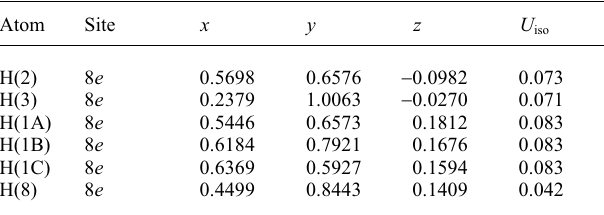
Table 2. Atomic coordinates and displacement parameters (in Å 2 )